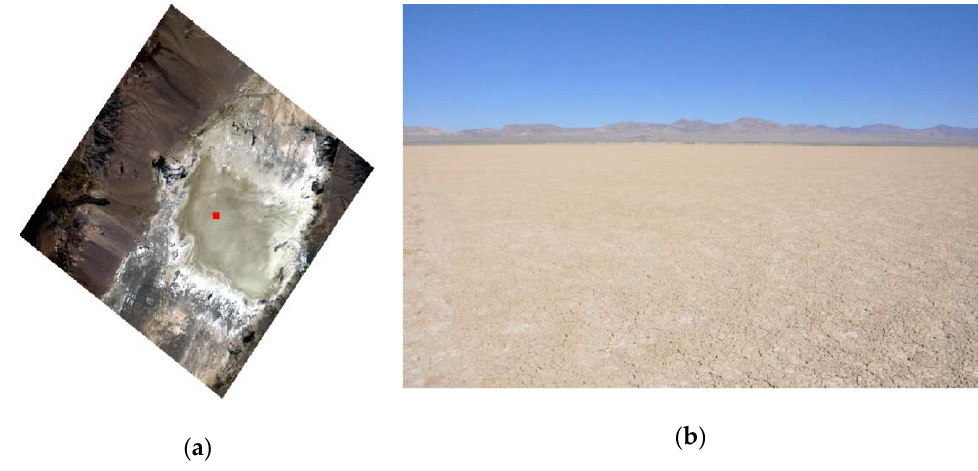
Figure 1. DESIS image of Railroad Valley Playa ( a ) and site view ( b ).